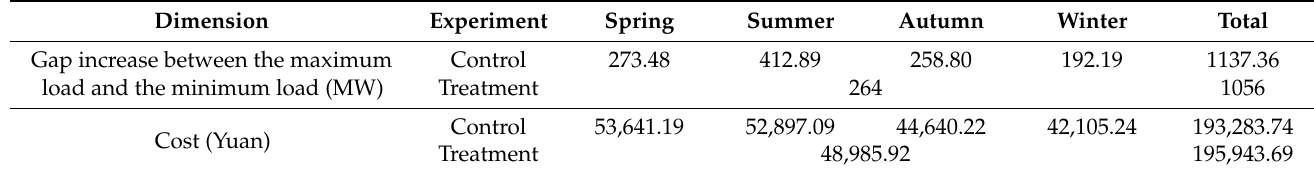
Table 10. The effect of the control group and treatment